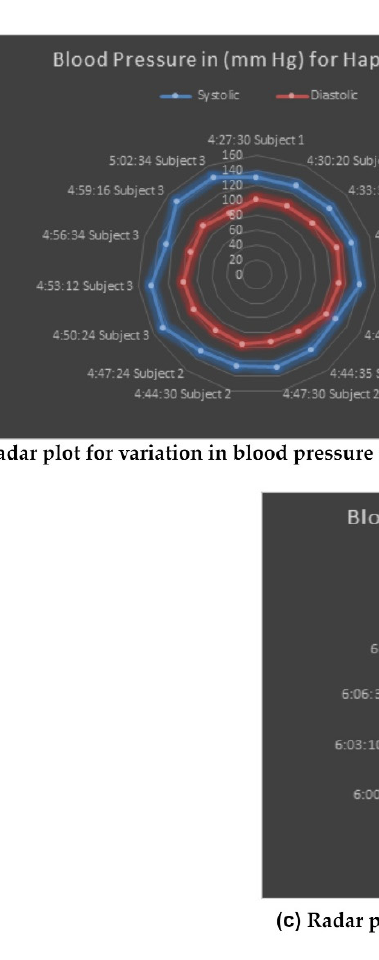
Figure 12. Radar plot for variation in blood pressure under happy, angry, and neutral state. Table 3. Details of happy, sad, and angry videos for experimental analysis.